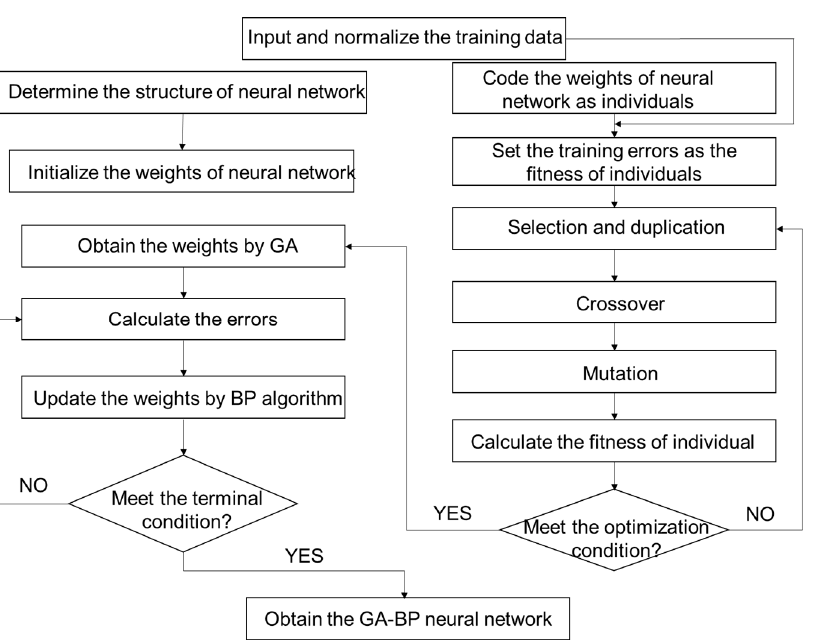
Figure 3. Flowchart of training GA-BPNN.